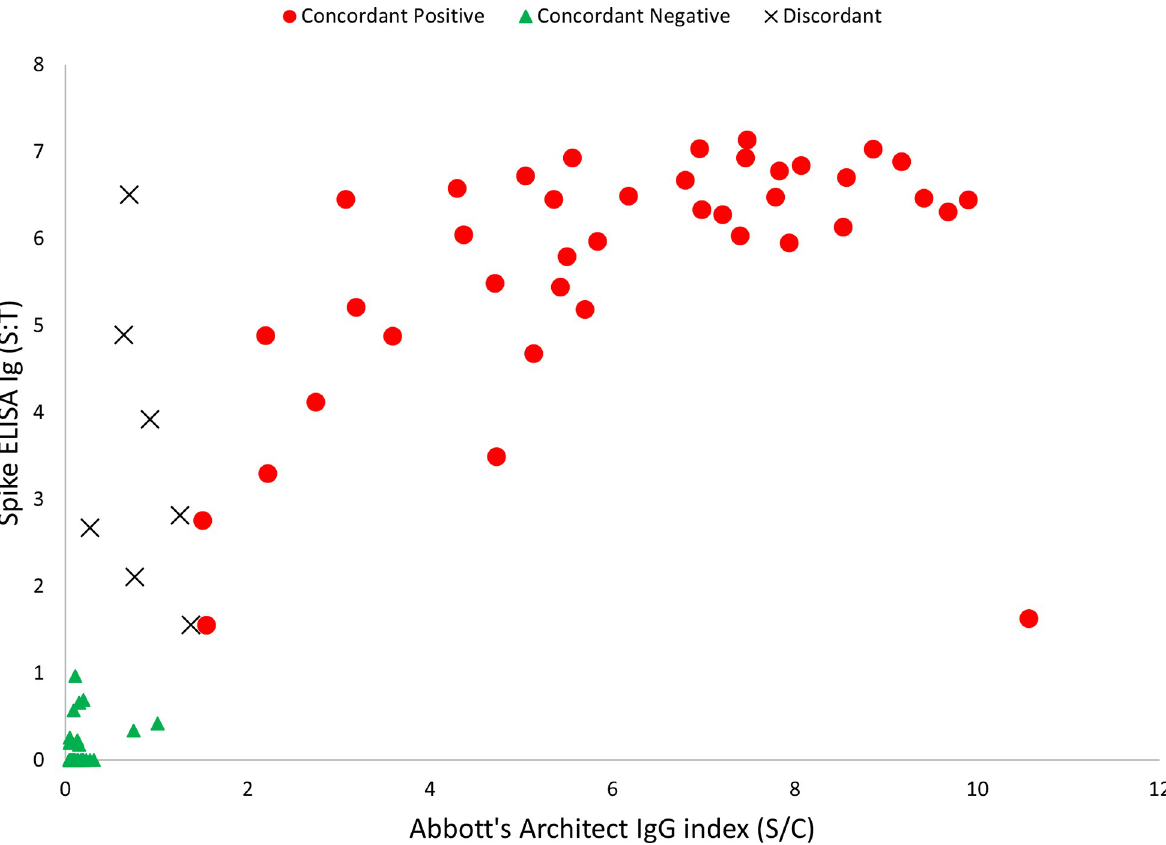
Fig 1. Comparison of the IgG signal detected by the SARS-CoV-2 spike protein ELISA (spike ELISA) and the Abbott Architect TM SARS-CoV- 2 IgG assay (Architect) (n = 105 serum samples). IgG signal to threshold (S:T) value only for Spike ELISA and the Abbott Architect TM SARS-CoV- 2 IgG (Architect) assay using 105 serum samples. For the Spike ELISA, S/T value was calculated by dividing the OD for 1:100 dilution by 0.4; and, for Architect the system calculates a calibrator mean chemiluminescent signal and the default result unit is index (S/C). Cut-off value was 1 and 1.4 for Spike ELISA and the Architect, respectively. The 105 samples were differentiated into: concordant positive (n = 40), concordant negative (n = 58) and discordant (n = 7).